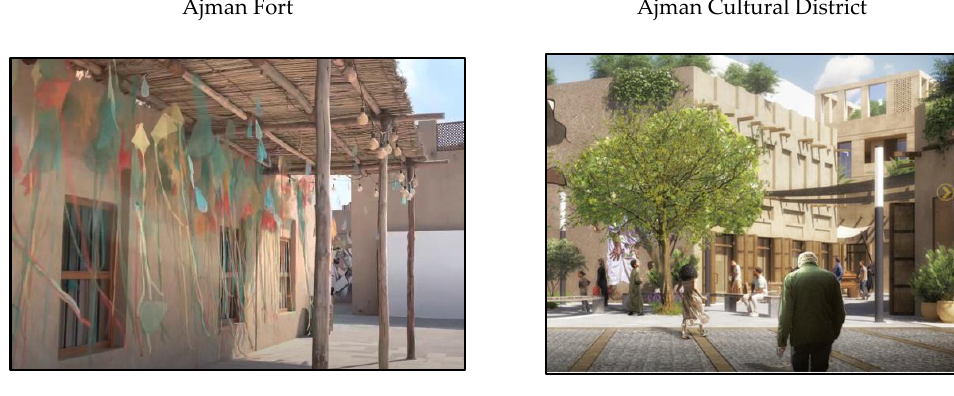
carefully placed furniture outside that allows for social gatherings or solitary reflection.